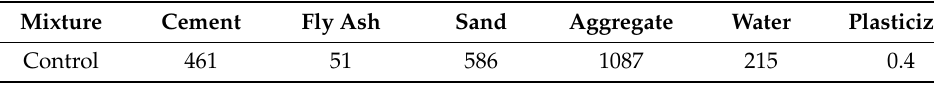
Table 3. Recipe of control concrete (kg/m 3 ).